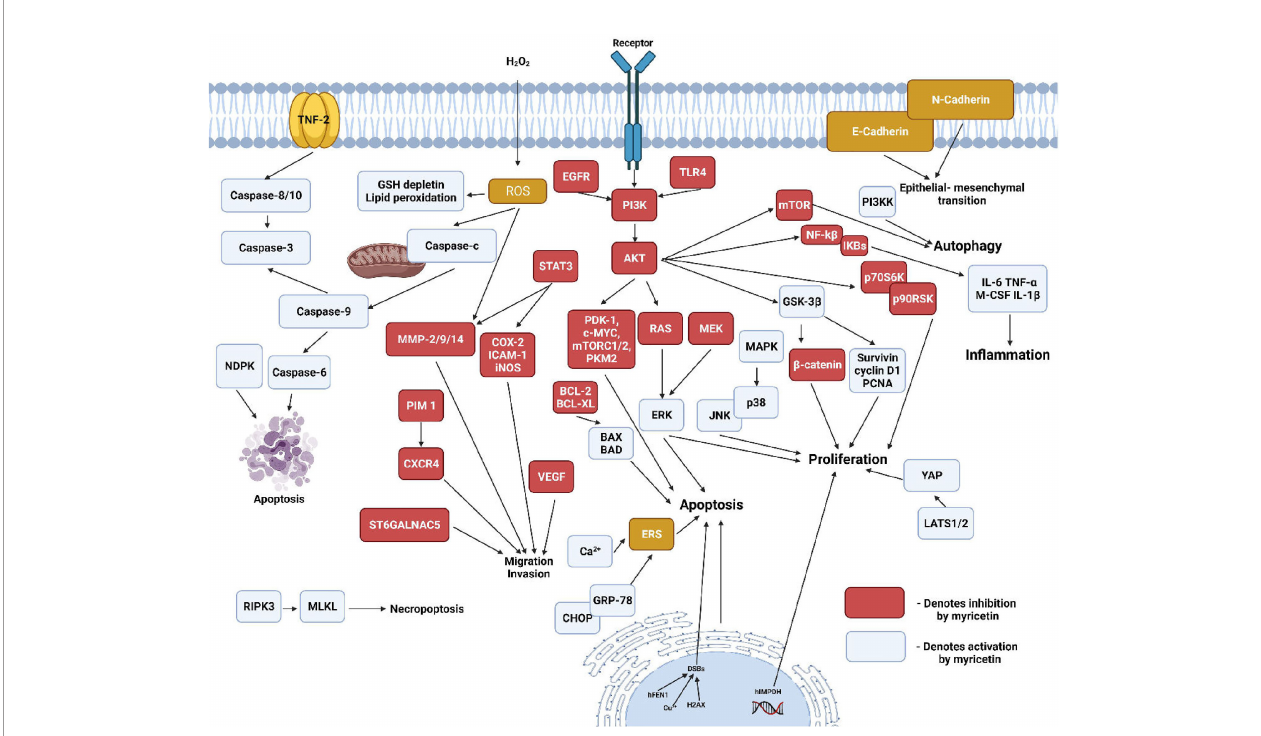
FIGURE 4 | Regulation of cellular pathways by myricetin. (Nucleoside diphosphate kinase-NDPK, Receptor-interacting serine/threonine-protein kinase 3-RIPK3, Mixed lineage kinase domain-like-MLKL, C-X-C chemokine receptor type 4- CXCR4, ST6 N-Acetylgalactosaminide Alpha-2,6-Sialyltransferase 5- ST6GALNAC5, Phosphoinositide-dependent kinase 1-PDK 1, Pyruvate kinase M2-PMK2, Toll-like receptor 4- TLR4, CCAAT/enhancer binding protein homologous protein-CHOP, Glucose-regulated protein 78-GRP-78, Endoplasmic reticulum stress-ERS, Proliferating cell nuclear antigen-PCNA, Yes-associated protein-YAP-1, Large tumour suppressor kinase-1/2- LATS1/2, p90 ribosomal S6 kinase-p90RSK, Ribosomal protein S6 kinase